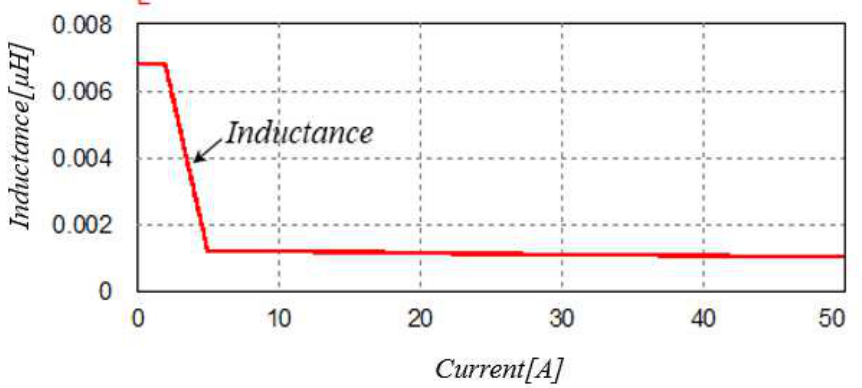
Figure 6. Simulation schematic. ( a ): Conventional bidirectional boost-buck converter. ( b ): Proposed heterogenous reactor bi-directional boost-buck converter. ( c ): Control DLL block diagram.